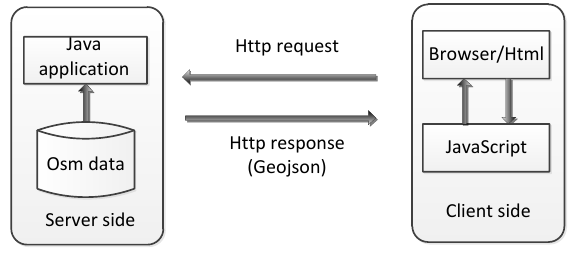
Figure 2: The system architecture of the web application for 3D construction of building